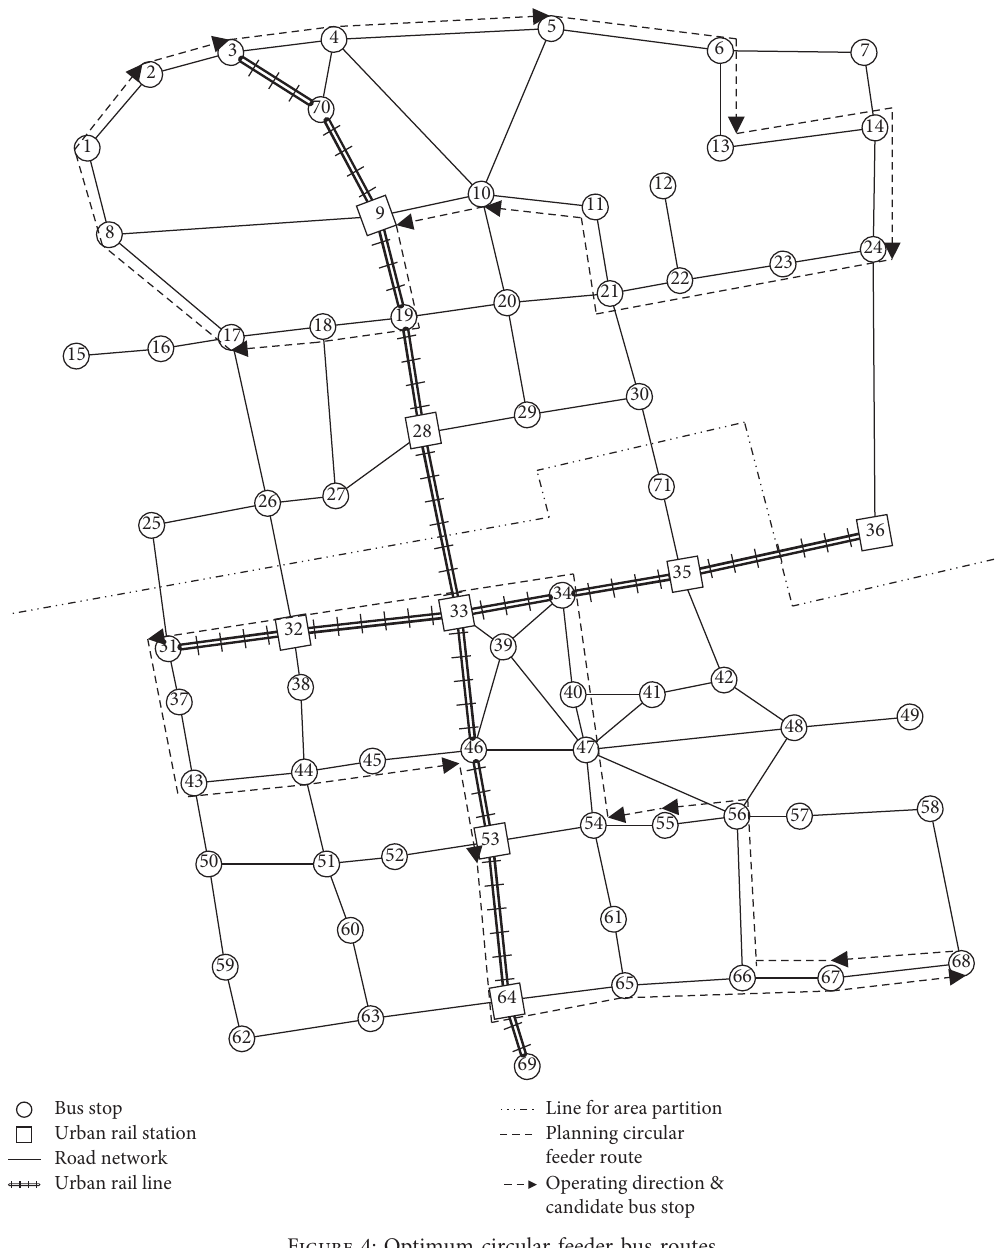
Figure 4: Optimum circular feeder bus